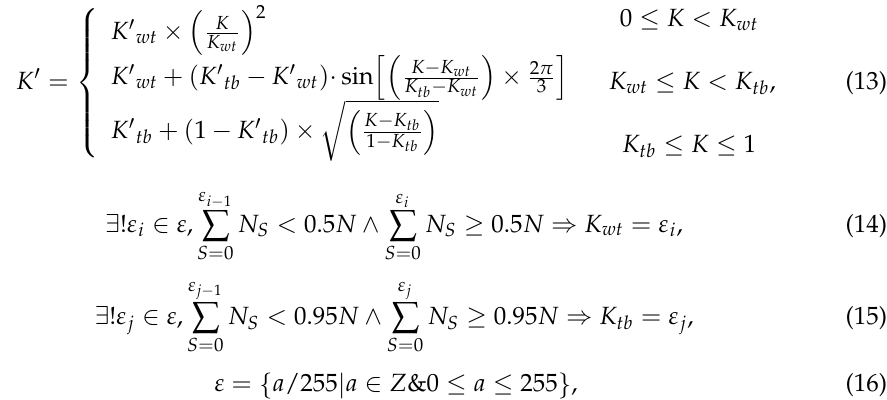
where N is the total number of pixels of the entire image and N S is the pixel number of value